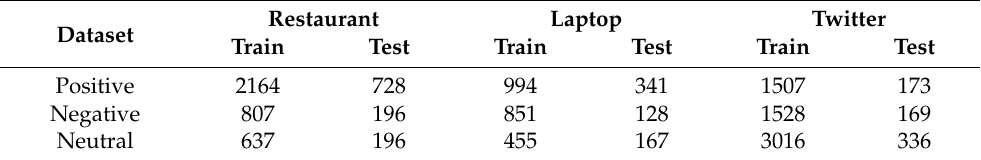
Table 1. Statistics from datasets.